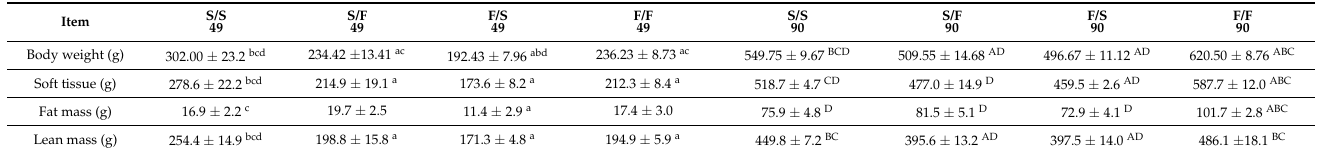
Table 2. Body weight and parameters of body composition.